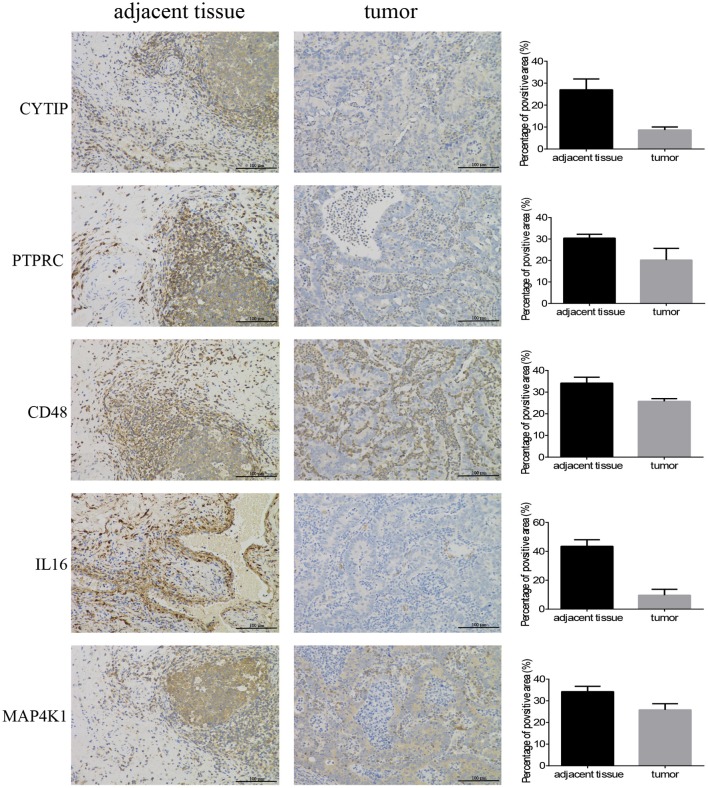
Immunohistochemistry. Five hub genes expression in 12 pairs of bladder cancer and adjacent tissues (magnification 200×).